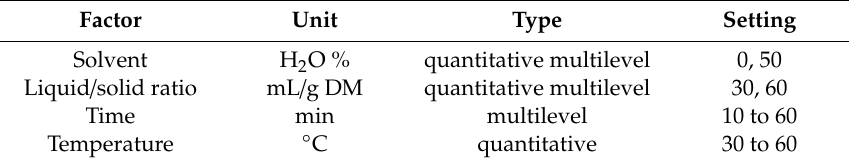
Table 1. Factors set in the ultrasound-assisted extraction (UAE) experimental design.